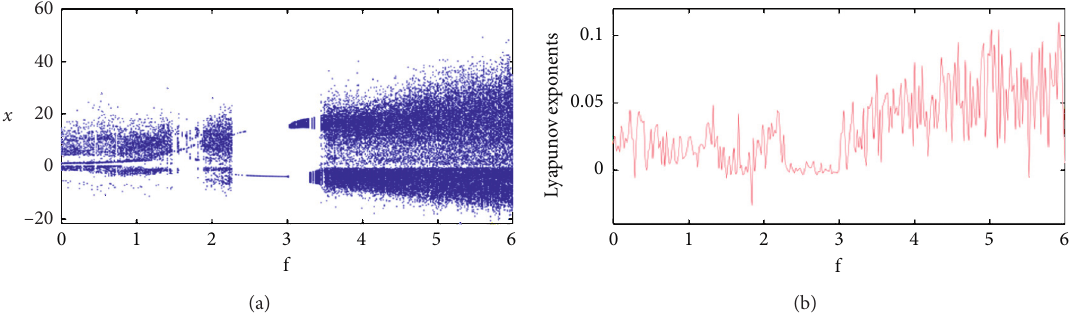
Figure 7: System bifurcation diagram (a) and Lyapunov exponents variation (b) in the total system risk value as the hysteresis modulation intensity f varies.